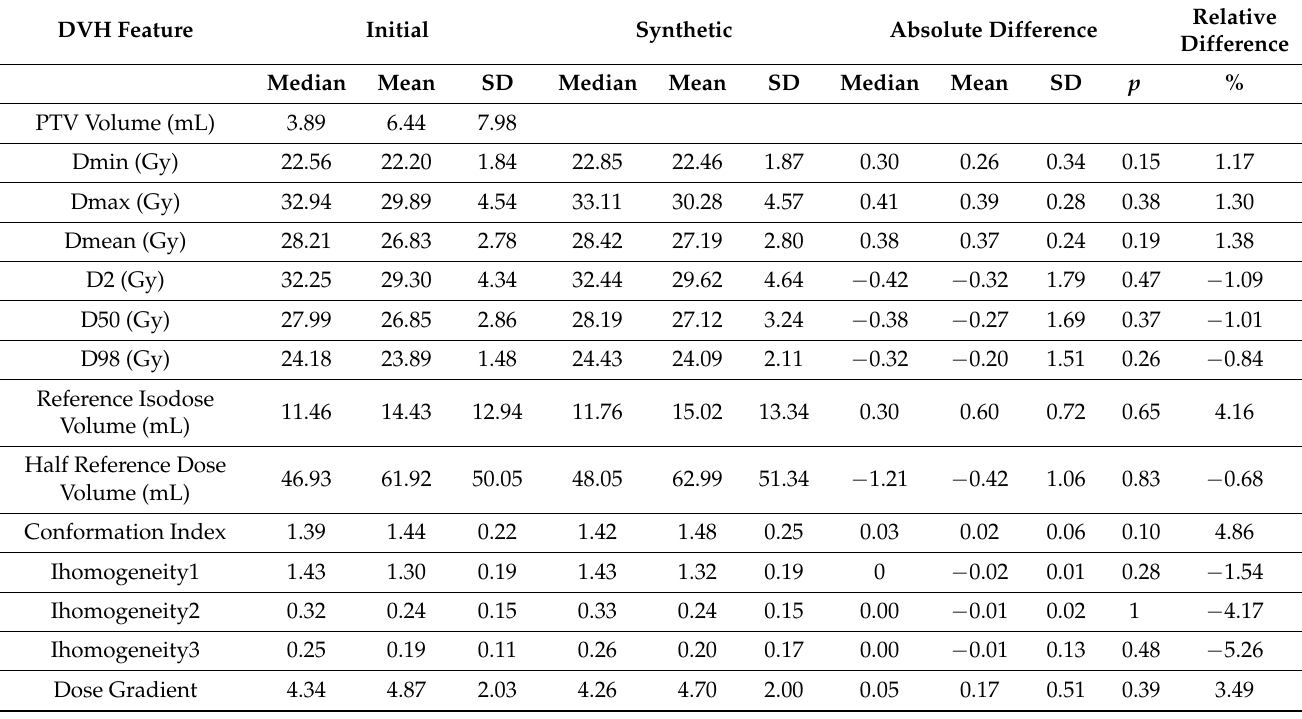
Table 4. Dose-volume histogram (DVH) comparisons between the initial dose and the synthetic dose maps for the PTVs. DVH